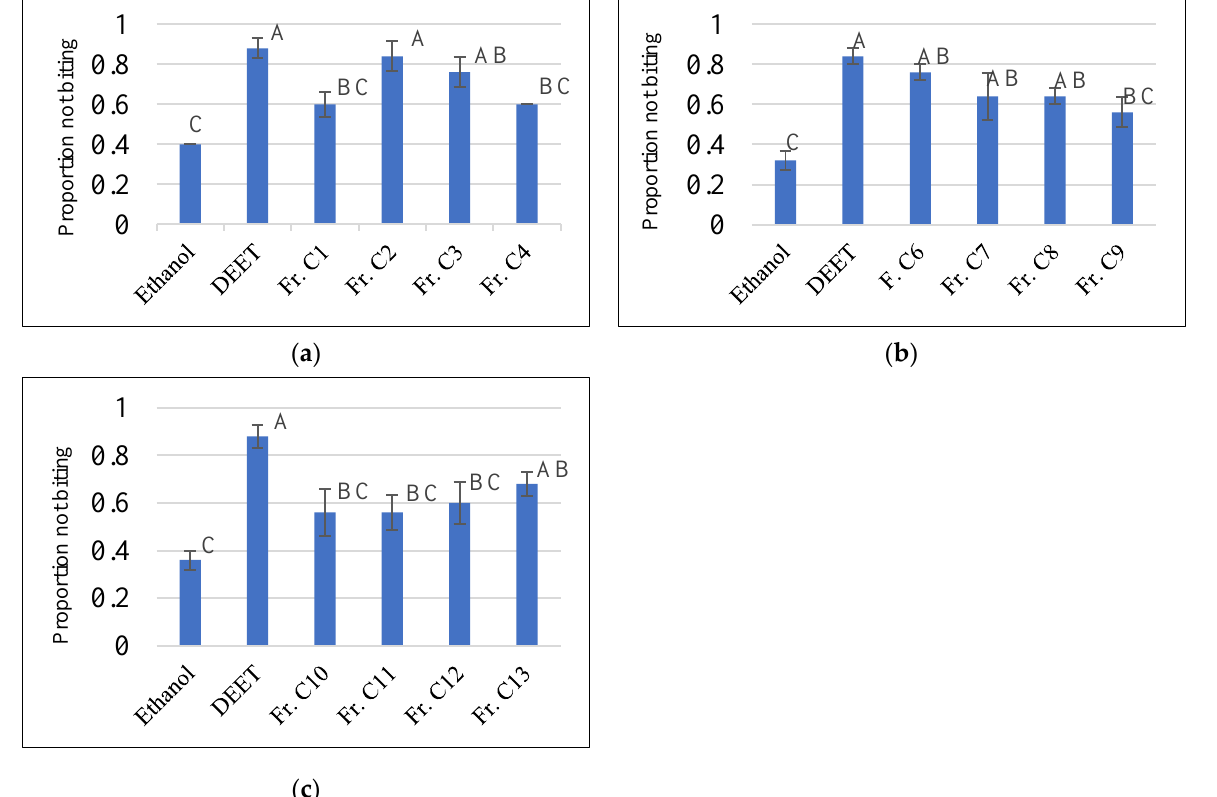
Figure 3. Proportion not biting values of fractions of methanolic extract part C of Stenaria nigricans and DEET against Aedes aegypti . Subfigures ( a – c ) represent data of fractions 1–4, 6–9 and 10–13, repectively. Ethanol was used as a solvent control. The fractions were tested at 10 µg/cm 2 . DEET at 25 nmol/cm 2 was used as a positive control. Means within the bars in each group followed by the same letter are significantly different (Ryan-Einot-Gabriel-Welsch multiple range test ( p ≤0.05).